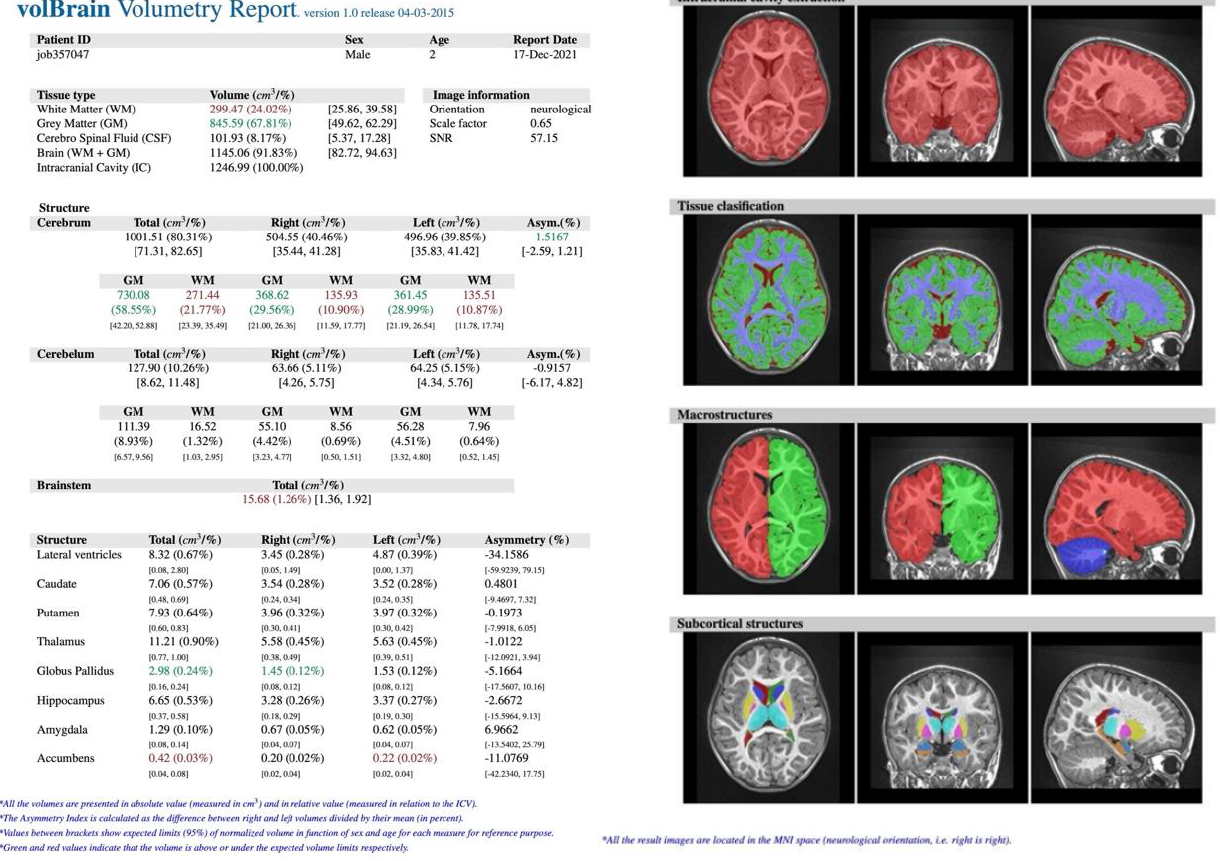
Figure 3. VolBrain analysis of head MR of a 2.5 − year − old boy—no relevant abnormalities were detected. Source: own study.